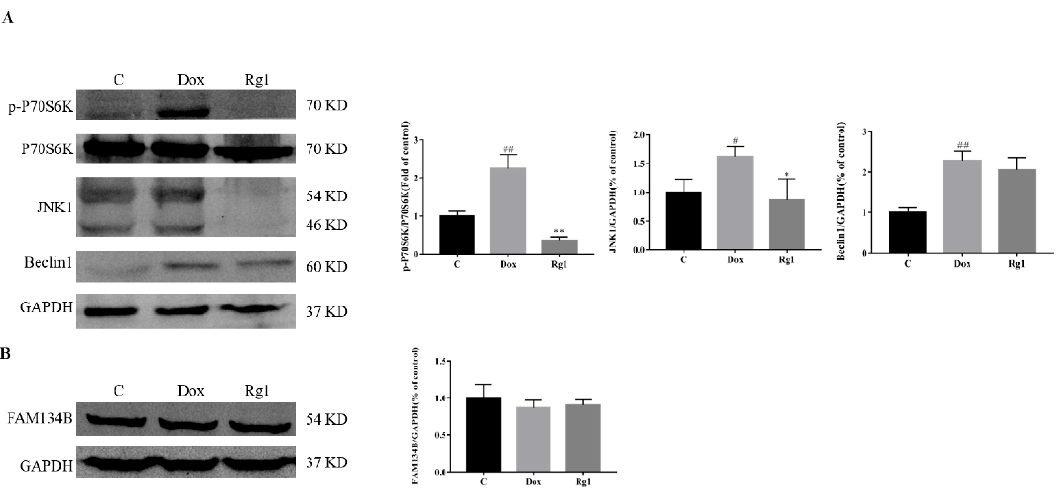
Figure 6. Effect of Rg1 on the autophagic pathway activated by endoplasmic reticulum stress in mice heart. ( A ) Expression of p-P70S6K, P70S6K, JNK1 and Beclin1 protein in mouse heart. ( B ) Expression of FAM134B protein in mouse heart, GAPDH was used as the loading control. # p < 0.05, ## p < 0.01 vs